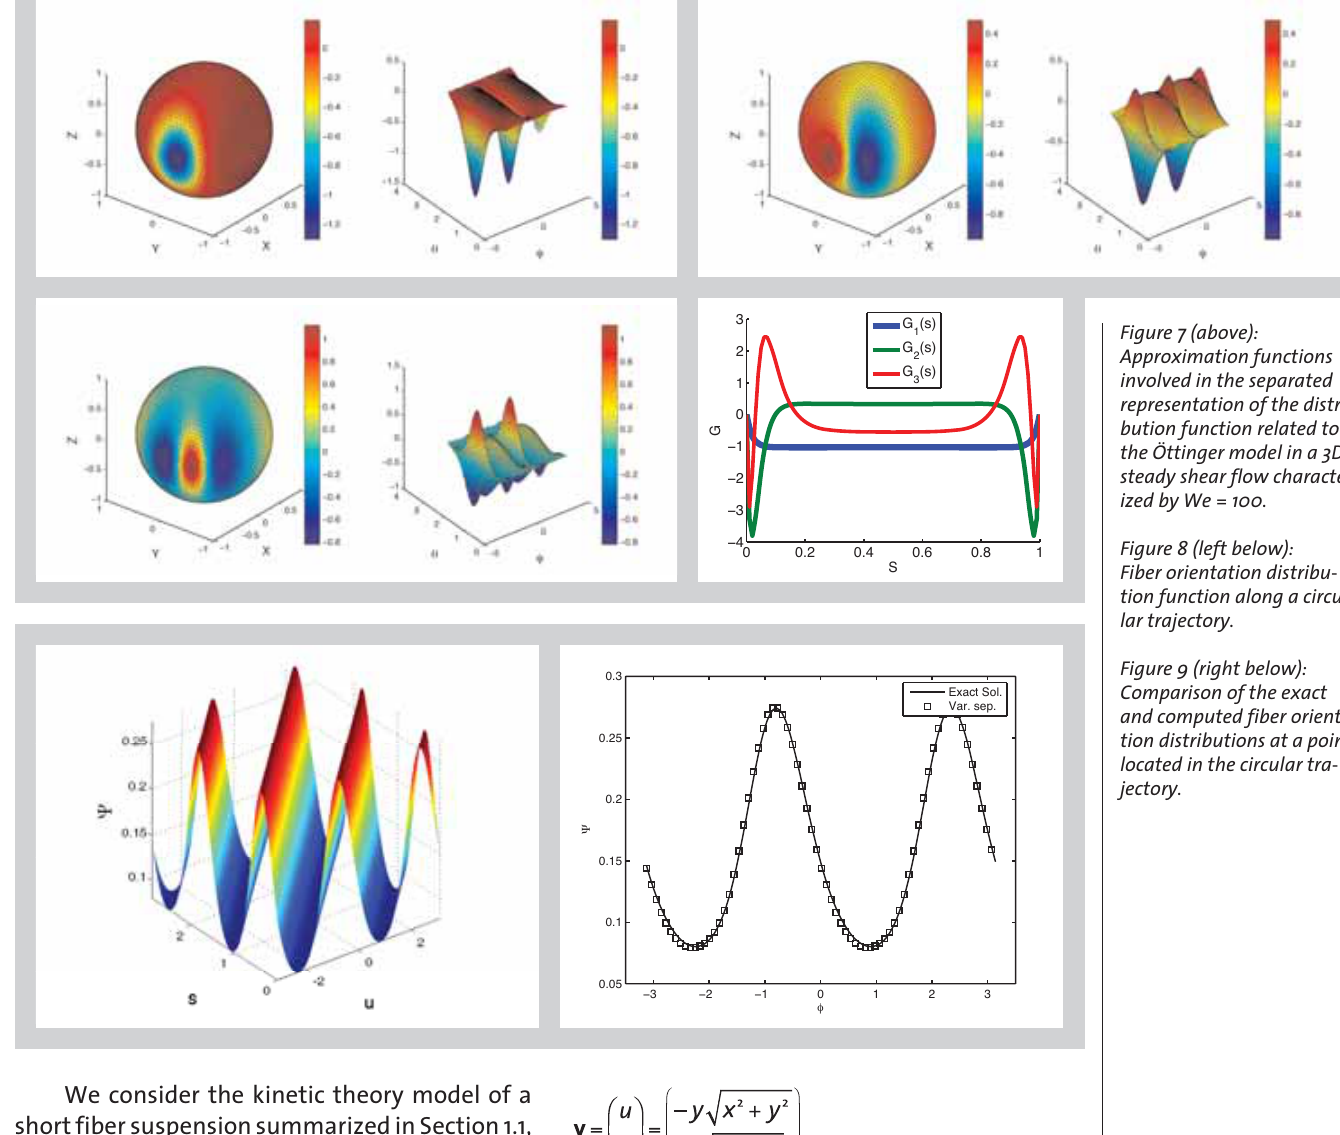
Figure 7 (above): Approximation functions involved in the separated representation of the distri- bution function related to the Öttinger model in a 3D steady shear flow character- ized by We = 100. Figure 8 (left below): Fiber orientation distribu- tion function along a circu- lar trajectory. Figure 9 (right below): Comparison of the exact and computed fiber orienta- tion distributions at a point located in the circular tra-